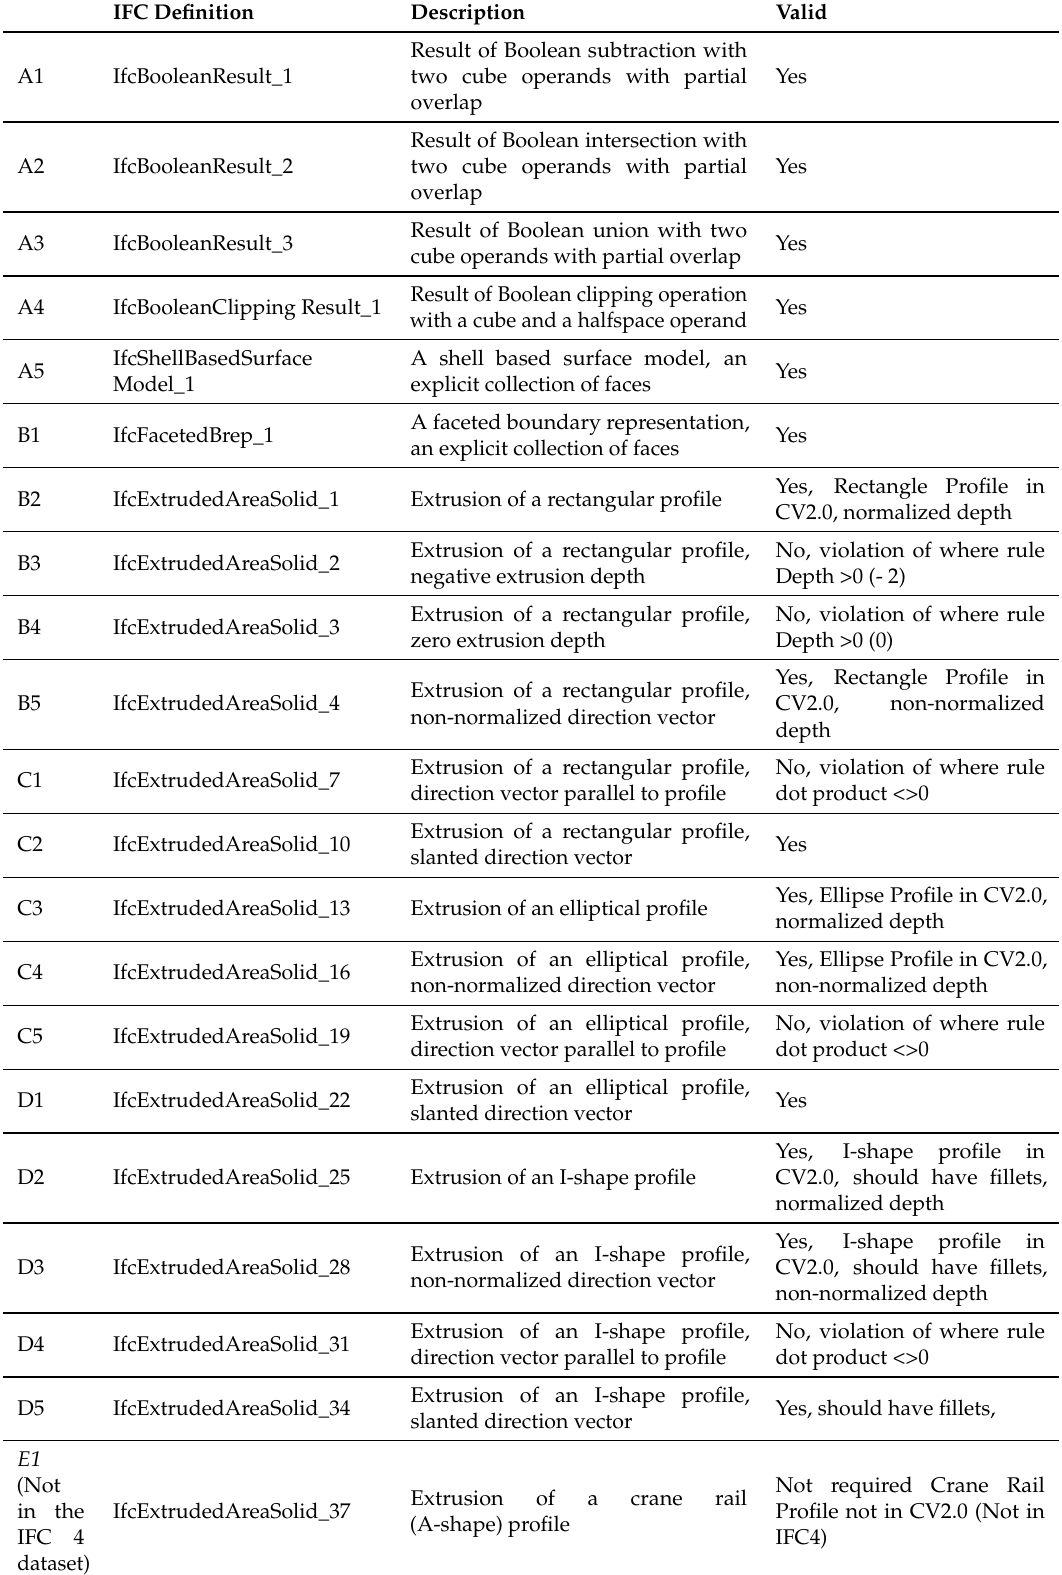
Table 4. Description of each object included in the IFC geometries set, in both IFC2x3 and IFC 4. The geometries written in italic are not included in the IFC 4 dataset since